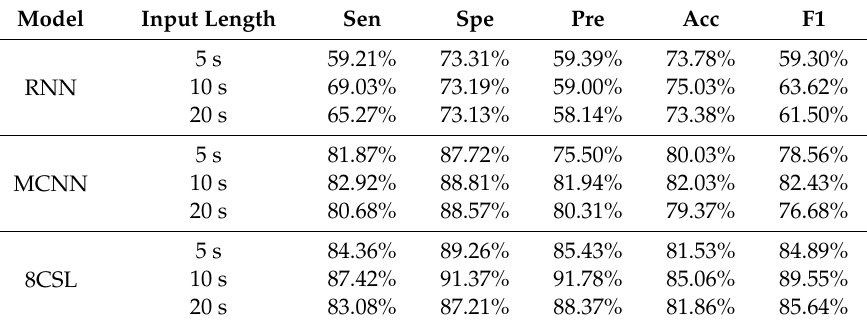
Table 4. Classification performance of the three models on the test